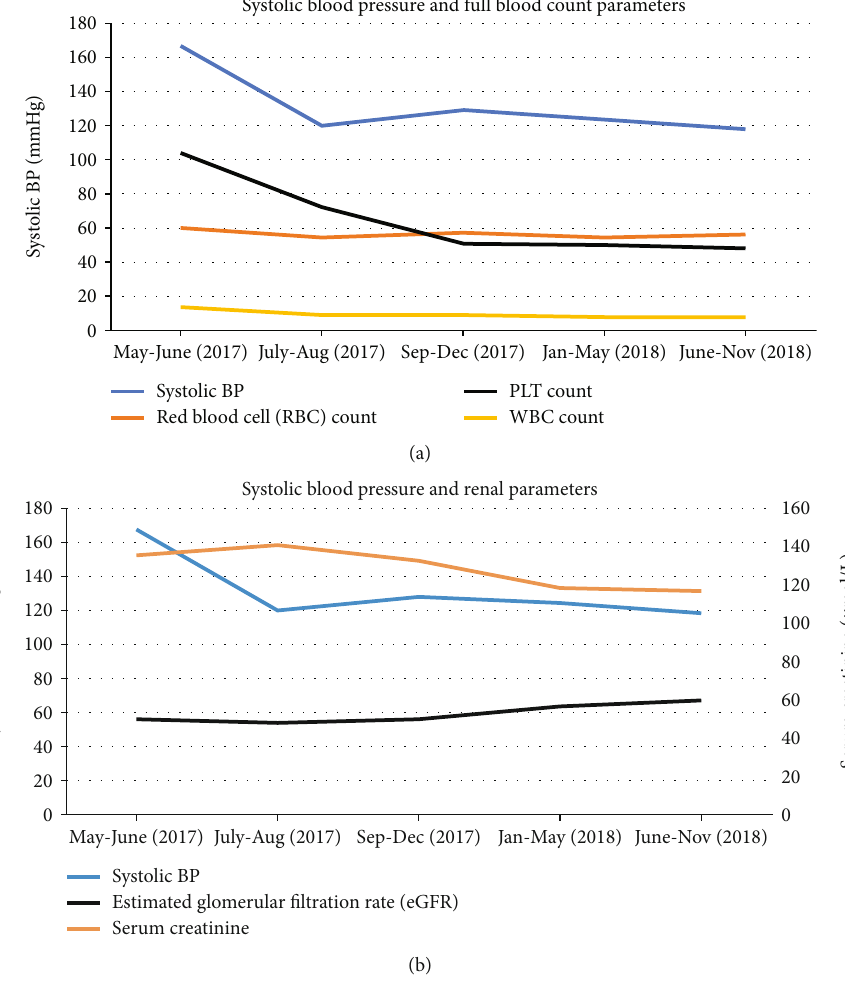
Figure 2: Case 1 — (a) Changes in BP alongside FBC. (b) Changes in BP alongside renal